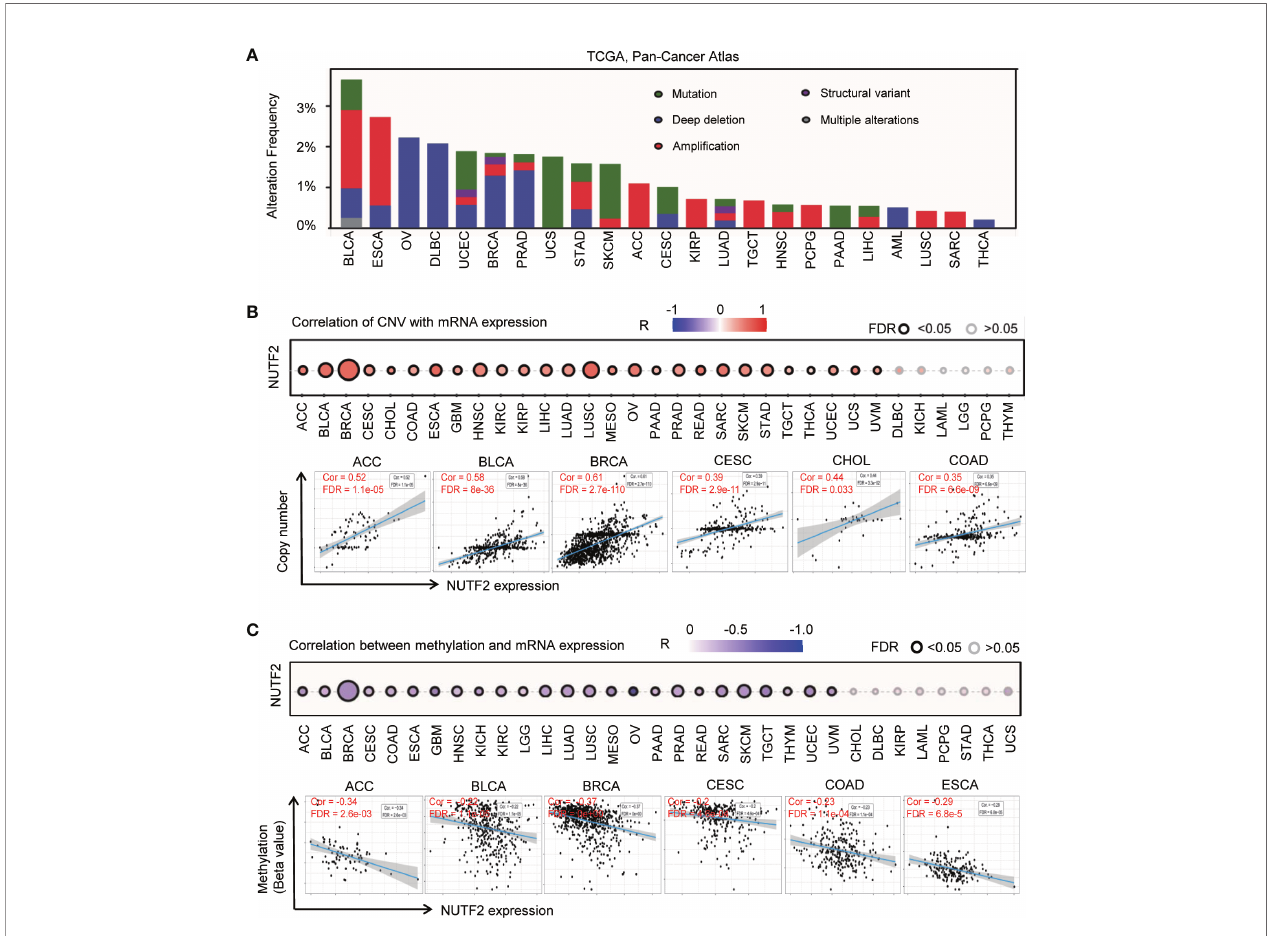
FIGURE 2 | Genetic and epigenetic alteration of NUTF2 in different types of tumors. (A) Mutation features of NUTF2 in TCGA tumors using the cBioPortal tool. Structural variation indicates insertion, inversion, translocation, or complex rearrangement of relatively large segments; multiple alterations indicate that two or more genetic alteration types occurred in speci fi c samples. (B) The association between copy number variation and NUTF2 expression was analyzed via the GSCA approach. (C) Correlation between NUTF2 expression level and DNA methylation across 33 types of